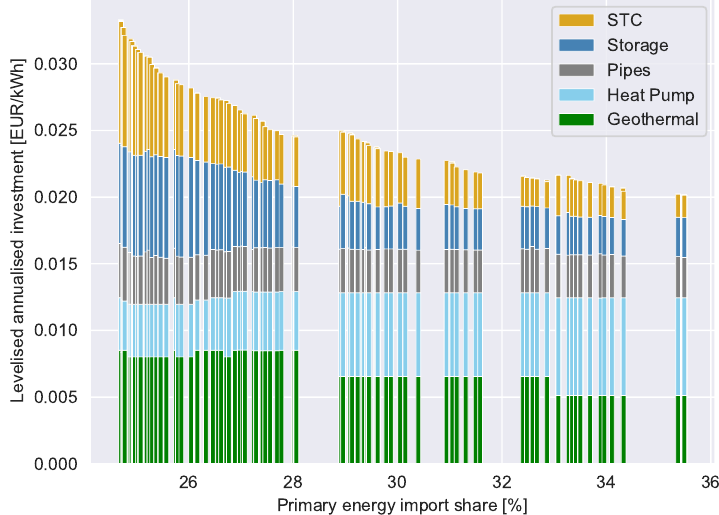
Figure 5. Bar chart showing the contribution of different technologies to the levelised annualised investment costs. The cost of the auxiliary domestic hot water (DHW) boilers has been omitted since it is the same for all solutions